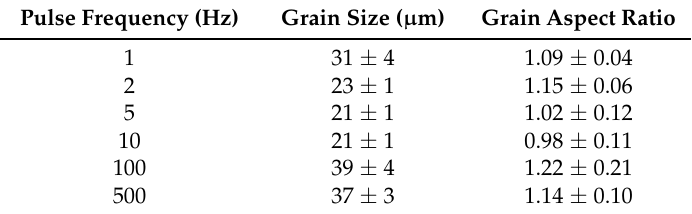
Table 2. Grain size and grain aspect ratio of the samples fabricated by different pulse